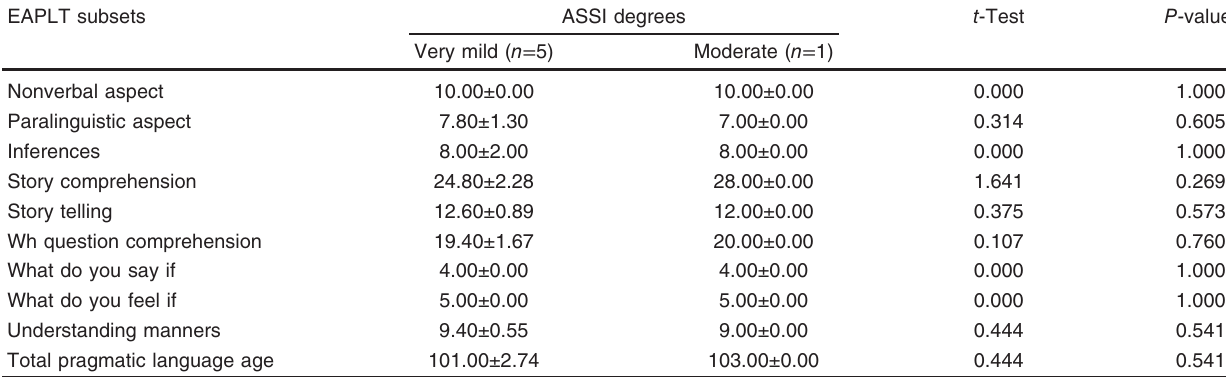
Table 11 Relation between stuttering severity measured by Stuttering Severity Instrument for Children and Adults − Arabic version, and pragmatic language development in children in age group I (4 years 1 month 1 day to 5 years 12 months 31 days) using independent sample t